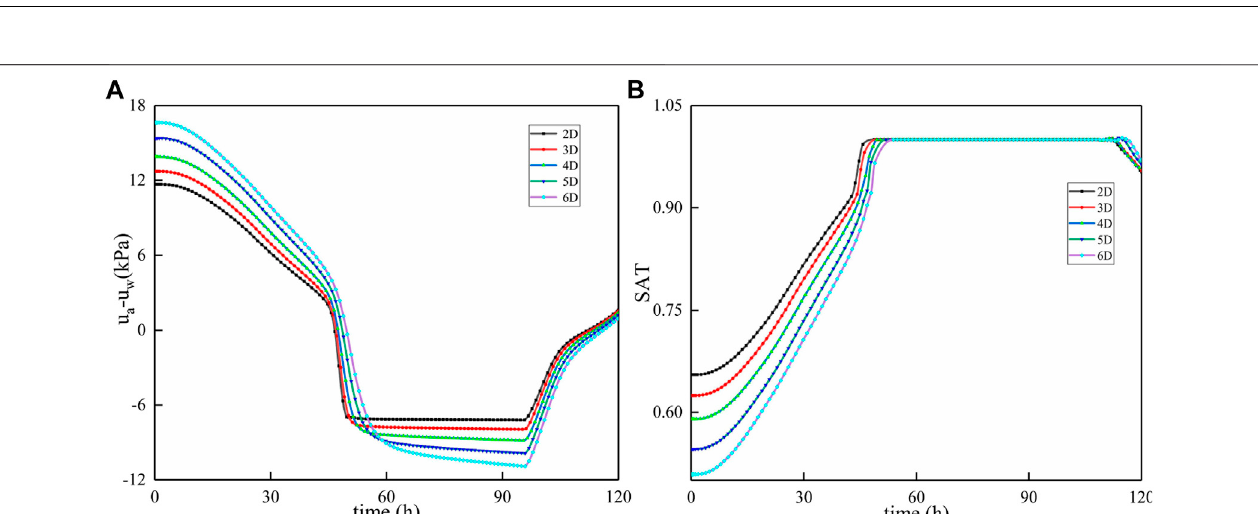
FIGURE 11 | Matrix suction and saturation at monitoring Unit B with different pile spacings.